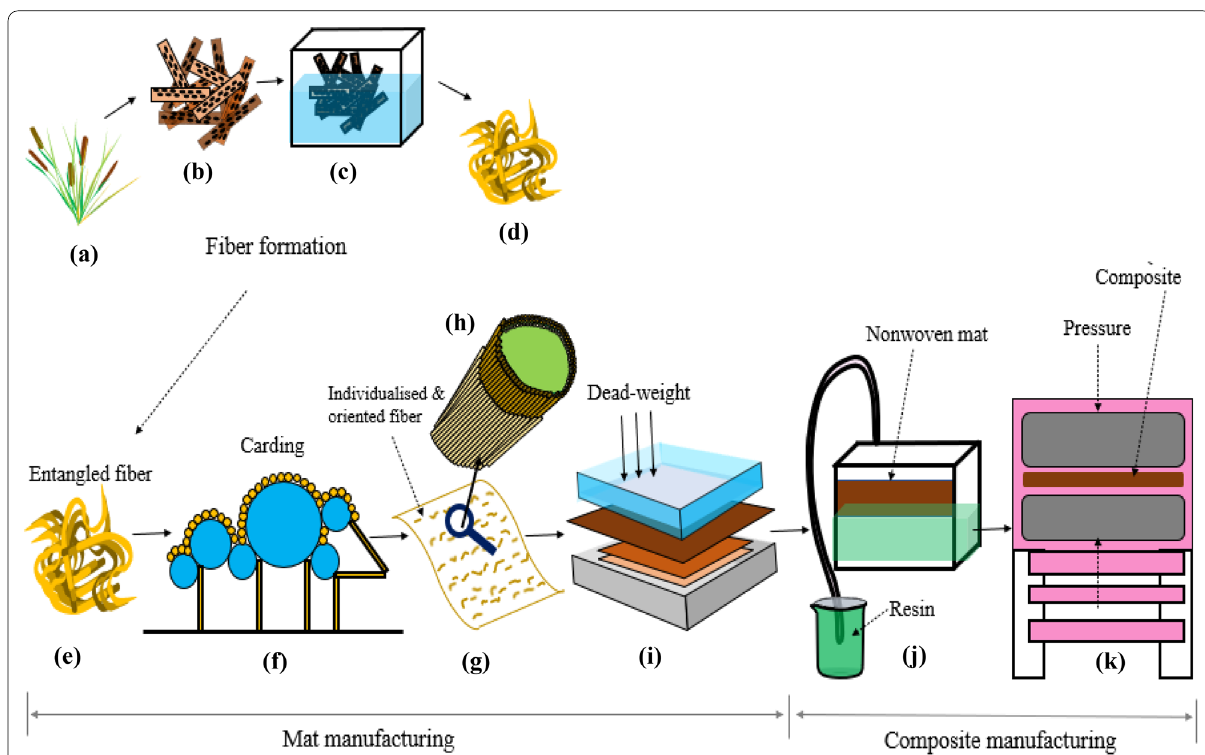
Fig. 1 Schematic diagram for manufacturing compression molded composites using fibers from cattail leaves. a Green cattail plants. b 6–10 cm precut cattail leaves. c Alkali retting of cattail (90 °C, 4 h) 5% KOH. d Extracted cattail fibers after drying. e Entangled fiber bundles fed to carding machine. f Disentangling and combing of fibers via carding process. g Individualized, parallelized, and oriented fiber bundle. h Single cattail fiber. i Dead weight applied on fiber layers placed on template. j Non-woven mat impregnation by resin in VARTM. k Impregnated mat sandwiched between metal plates, release film, and silicon pad (compression